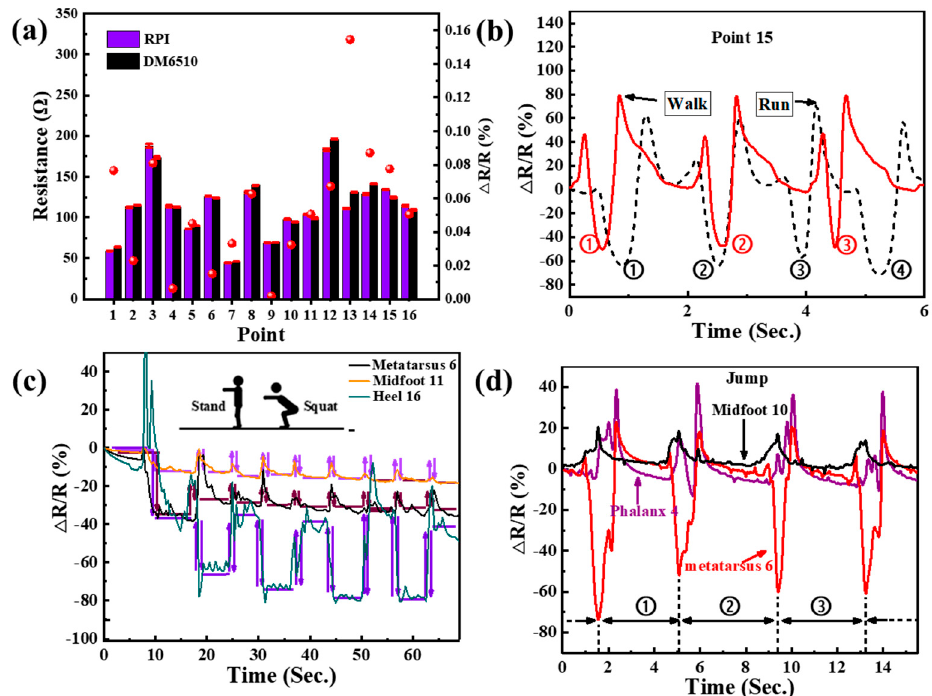
Figure 8. ( a ) Comparison of the resistance results of all 16 PGSPSs using the RPI system and DM6510, respectively, and the measurement error. ( b ) A gait test comparison between running and walking from sensor point 15. ( c ) Resistance response of sensors 6, 11, and 16 during squatting. ( d ) Resistance response of 4 (phalanx), 6 (metatarsus), and 10 (midfoot) during jumping.